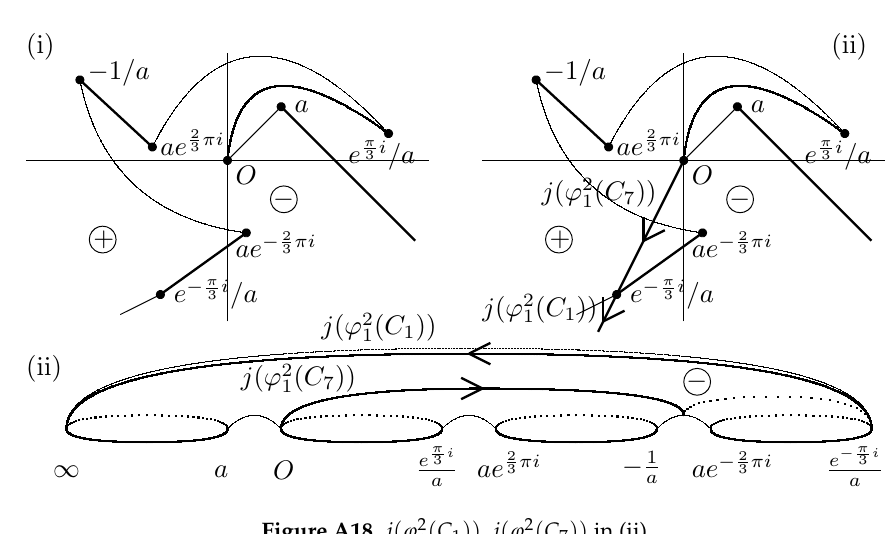
Figure A18. j ( ϕ 2